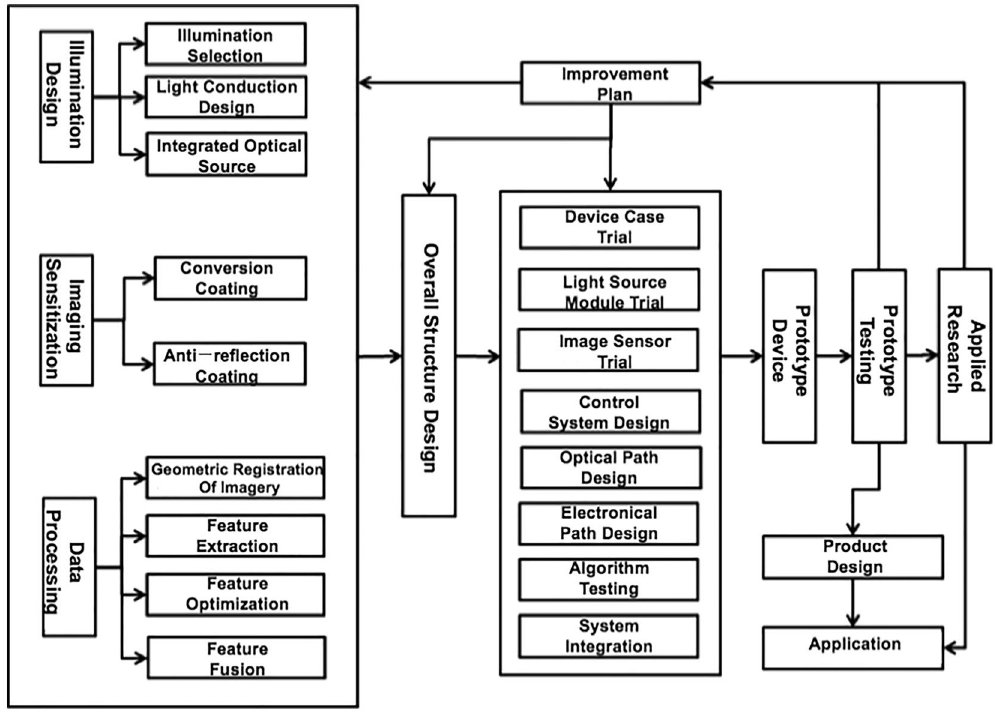
Figure 2. General technical route of the "one-click device for rapid visualization and extraction of latent evidence at the